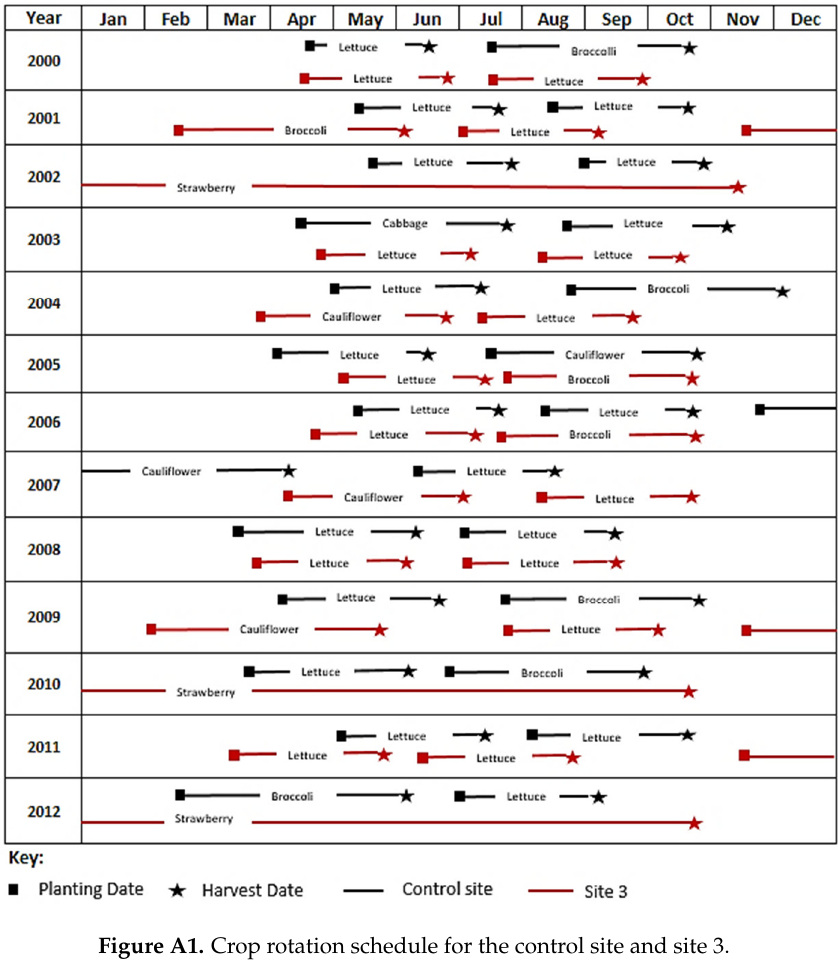
Figure A1. Crop rotation schedule for the control site and site 3.